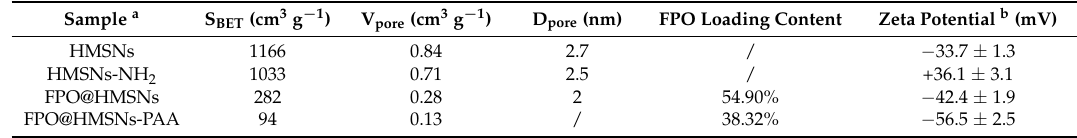
Table 1. Structure parameter, FPO-loading efficiency and zeta potential analyses of the synthesized samples (HMSNs, HMSNs-NH 2 and